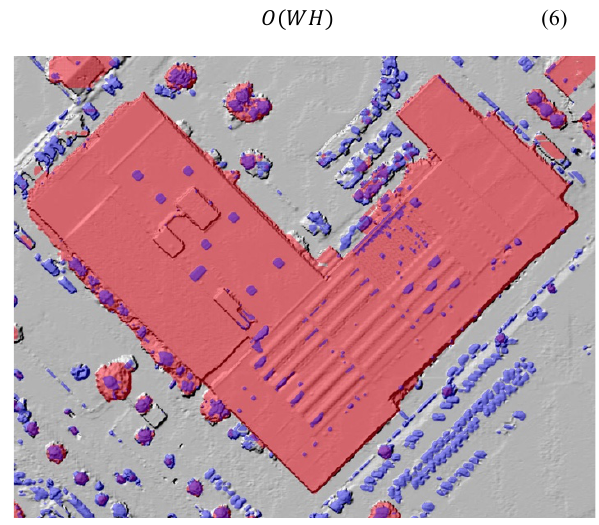
Figure 8. A combination of masks for two resolution levels. The red mask worked on a degraded DSM with a large 2 345 and 1 designed to capture large buildings. The blue mask worked on the full resolution DSM, but with smaller values for 2 345 and 1 .